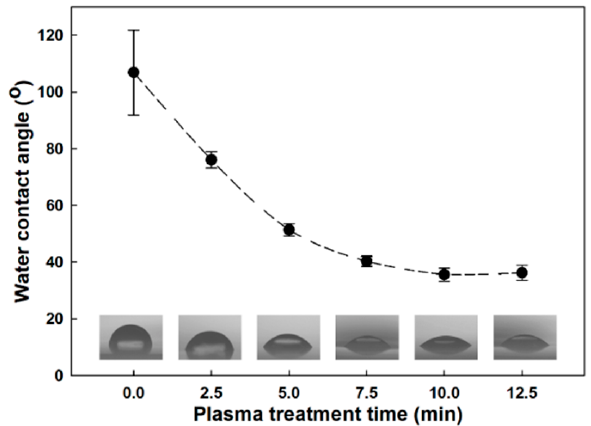
Figure 2. Water contact angle as a function of plasma treatment time for PP surface.